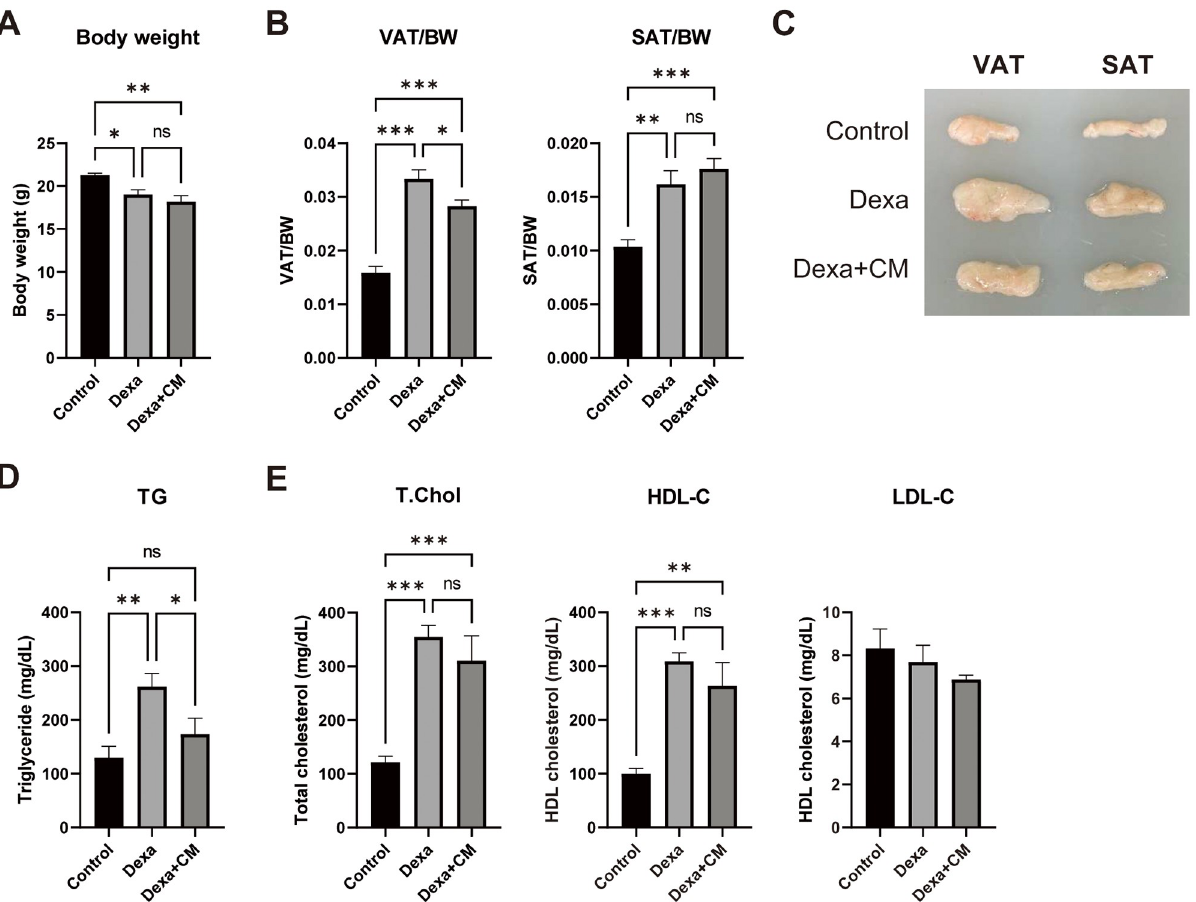
Fig 4. T-MSC CM reduces GC-induced visceral adiposity. BALB/c female mice were intraperitoneally injected with Dexa once daily for 5 weeks. T-MSC CM was injected twice a week. (A) Body weight was measured on the day of sacrifice. (B) Visceral (VAT) and subcutaneous (SAT) adipose tissue were harvested, and measured weights were normalized to body weight. (C) Photomicrograph of VAT and SAT. Serum levels of (D) triglycerides and (E) cholesterols were measured. Data are presented as mean ± SEM and were analyzed using one-way ANOVA (n = 5; ns, not significant; � P < 0.05, �� P <